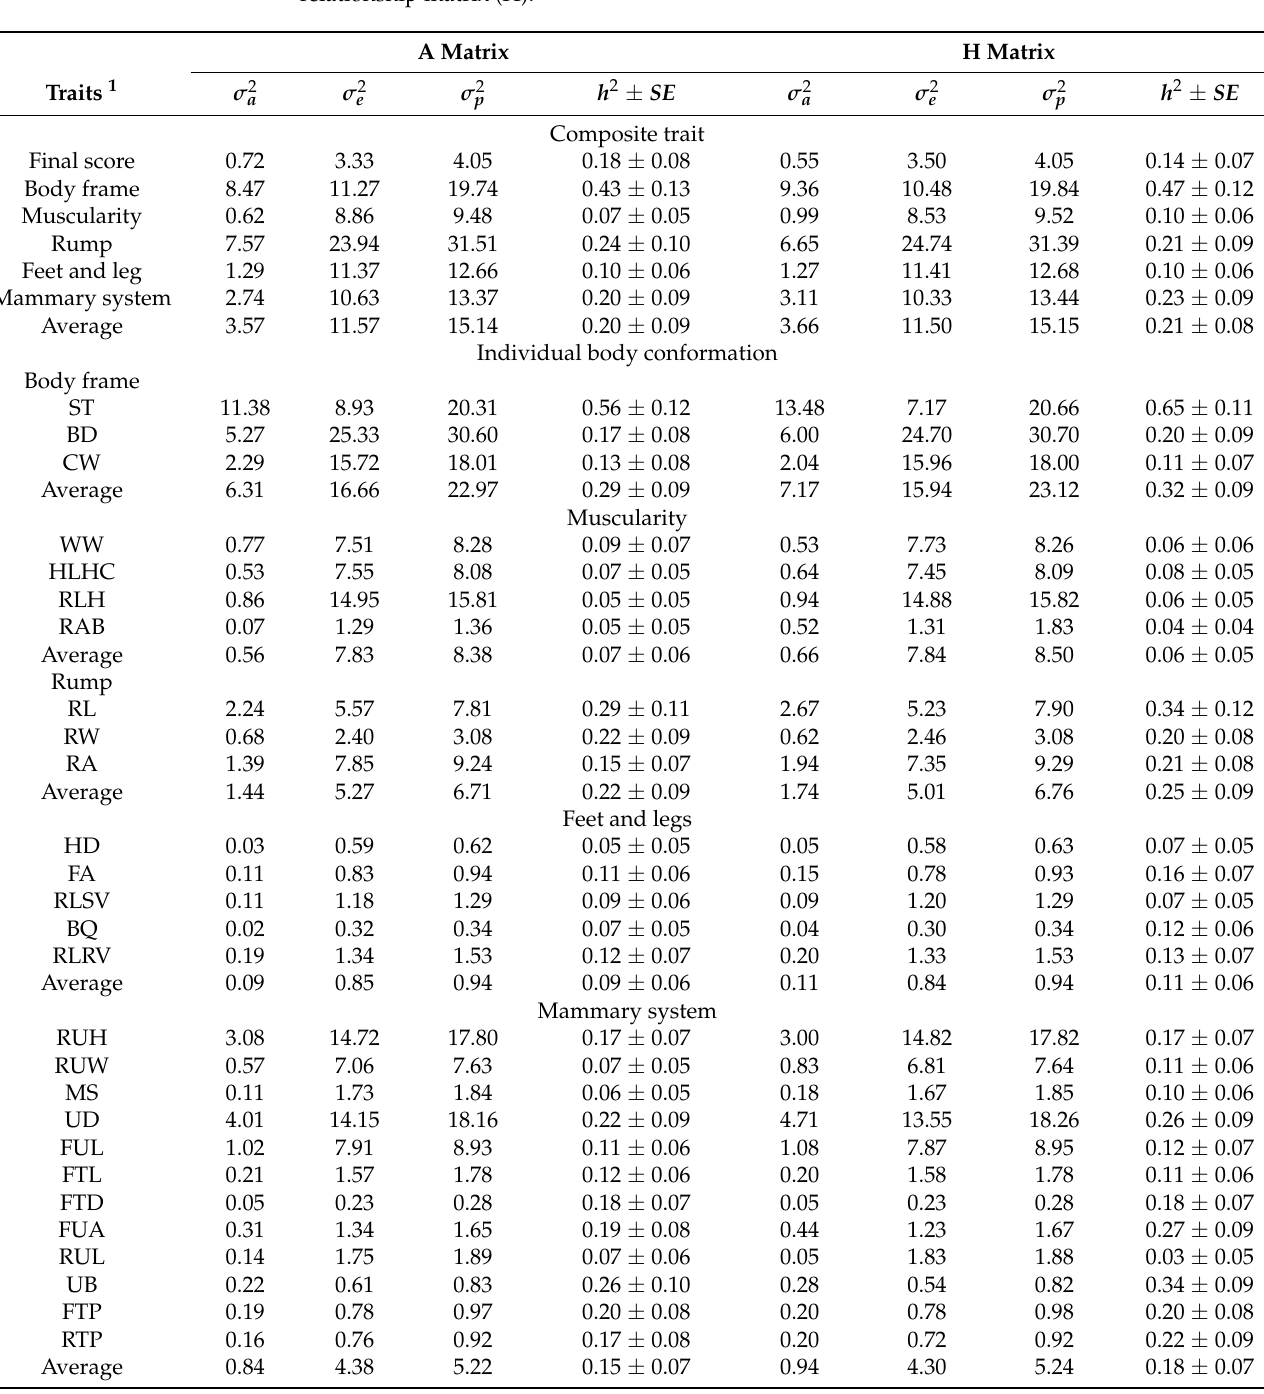
Table 2. Variance components and heritability of body conformation traits in dual-purpose Sim- mental Cattle obtained using the pedigree relationship matrix (A) and combined genomic-pedigree relationship matrix (H). A Matrix H